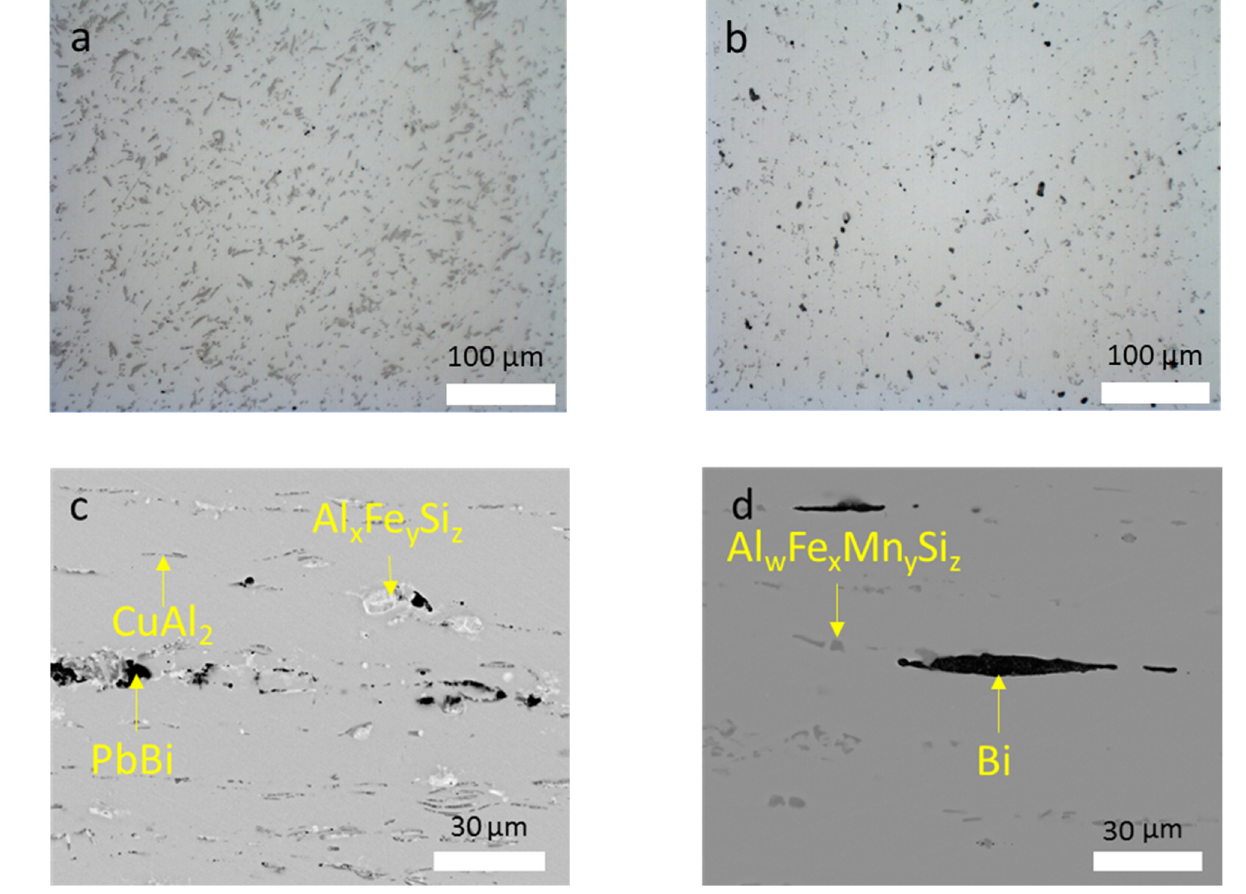
Figure 2. The microstructure of the two pin materials employed in this study, ( a ) LOM micrograph of the 2011 (radial section of the bar), ( b ) LOM micrograph of the 6026 (radial section of the bar), ( c ) SEM micrograph of the 2011 with phase identification confirmed by EDX (longitudinal section of the bar), and ( d ) SEM micrograph of the 6026 with phase identification confirmed by EDX (longitudinal section of the bar).